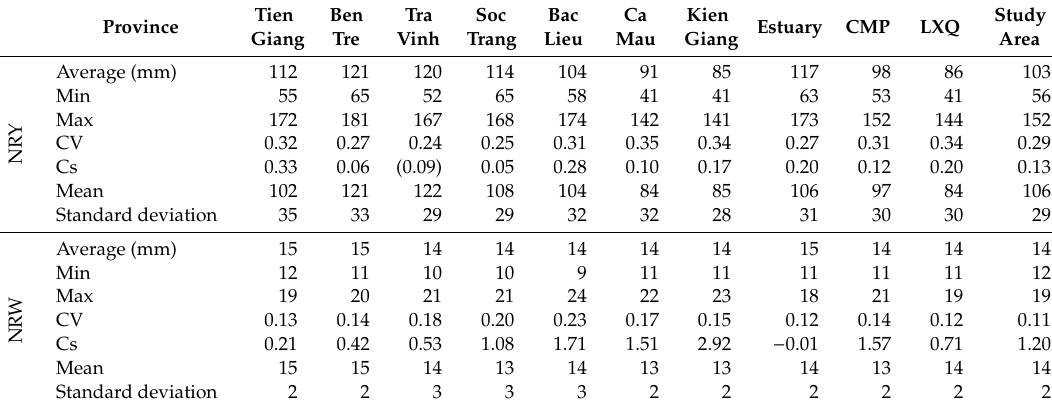
Figure 10. Number of consecutive days without more than 5 mm rain in the rainy season (NRW) ( a ) and throughout the year (NRY) ( b ). Table 2. Data on the number of consecutive nonrainy days in the year (number of consecutive days without rain in a year, NRY) and during the rainy season (number of consecutive days without rain in the rainy season, NRW) in the coastal provinces of the VMD and in the study area as a whole for the 1989–2017